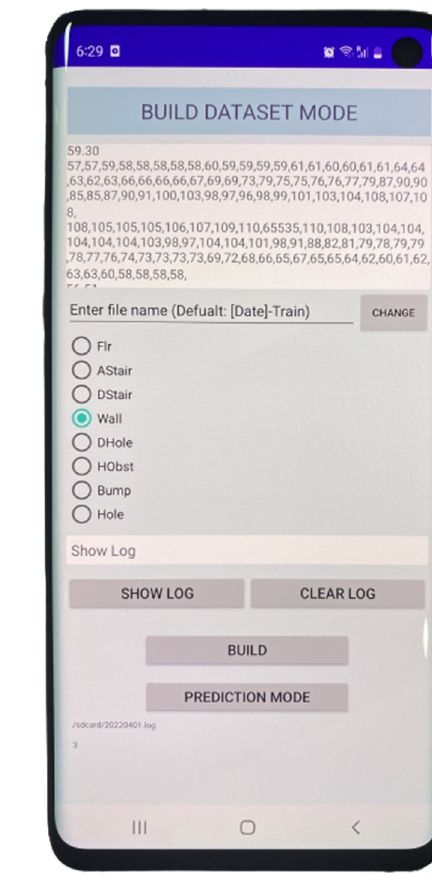
Figure 12. Slope.